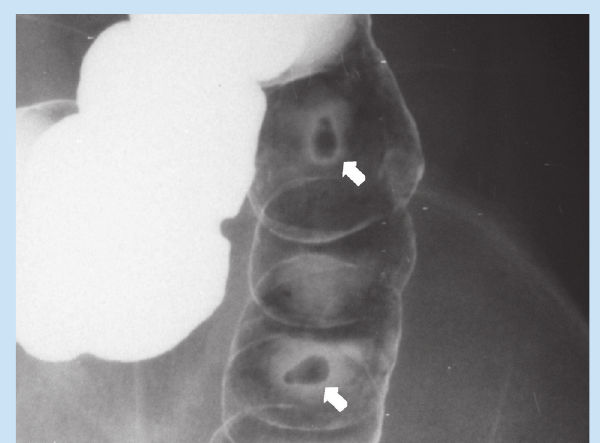
Fig. 1a. Grape pips (arrows) simulating polyps.